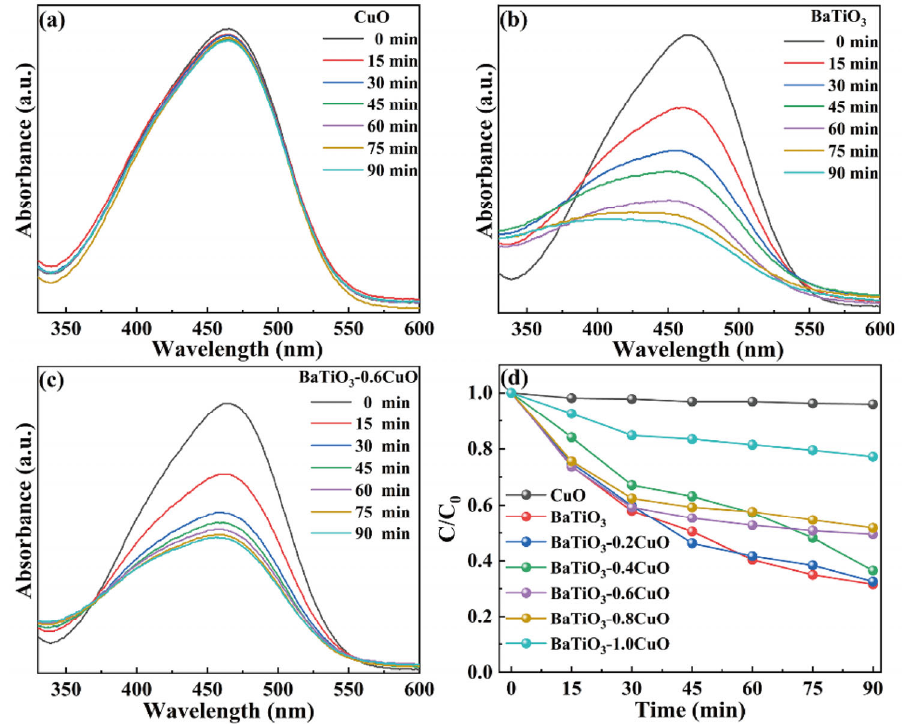
Fig. 5 UV–Vis absorption spectra of MO solutions undergoing different vibration time for (a) CuO NPs, (b) BaTiO 3 NWs, and (c) BaTiO 3 –0.6CuO. (d) Comparison of piezocatalytic activity of MO